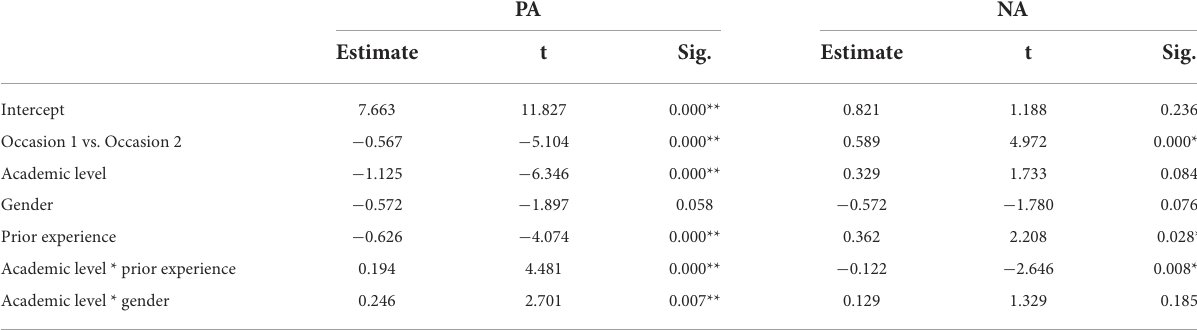
TABLE 3 Results of the multilevel linear model.